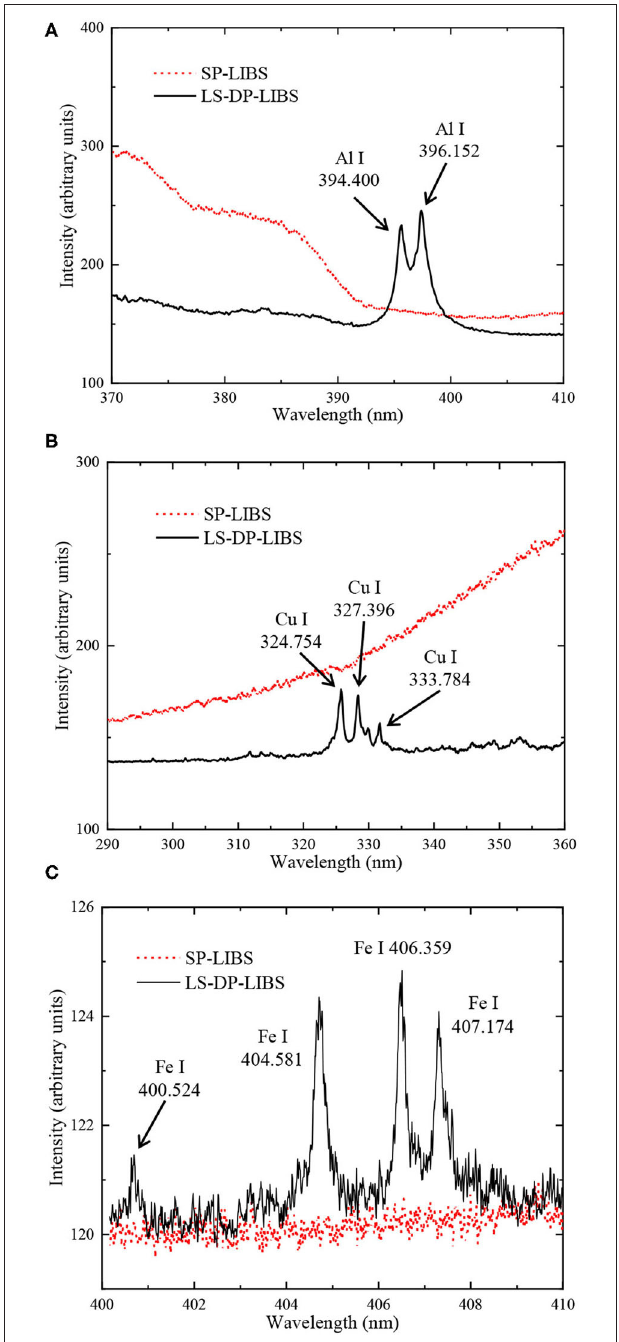
FIGURE 3 | Spectra of underwater measurement using SP-LIBS and collinear LS-DP-LIBS. (A) Al sample, (B) Cu sample, and (C) Fe sample. Experimental conditions: gate width: 100 ns, delay: 50 ns, accumulation: 50